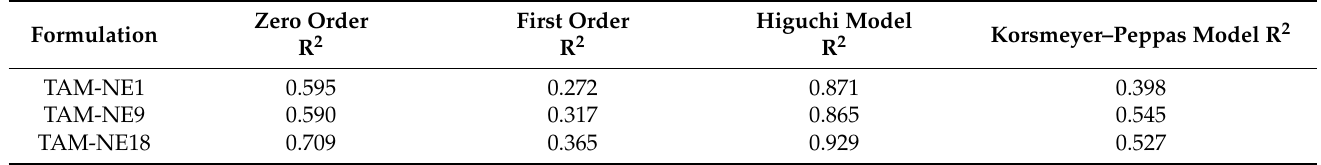
Table 5. In vitro drug release kinetics of TAM-NEs (R 2 is the correlation